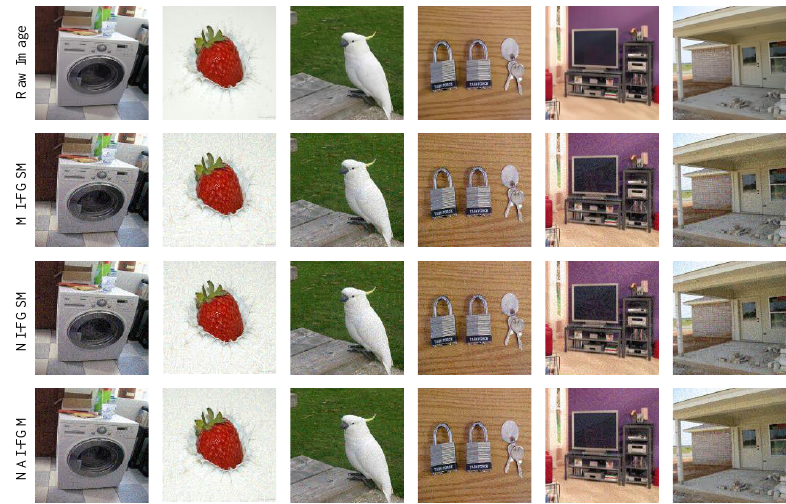
Figure 1. Raw images and adversarial examples after attack by MI-FGSM [13], NI-FGSM [14], and the proposed NAI-FGM on Inc-v3 [23].